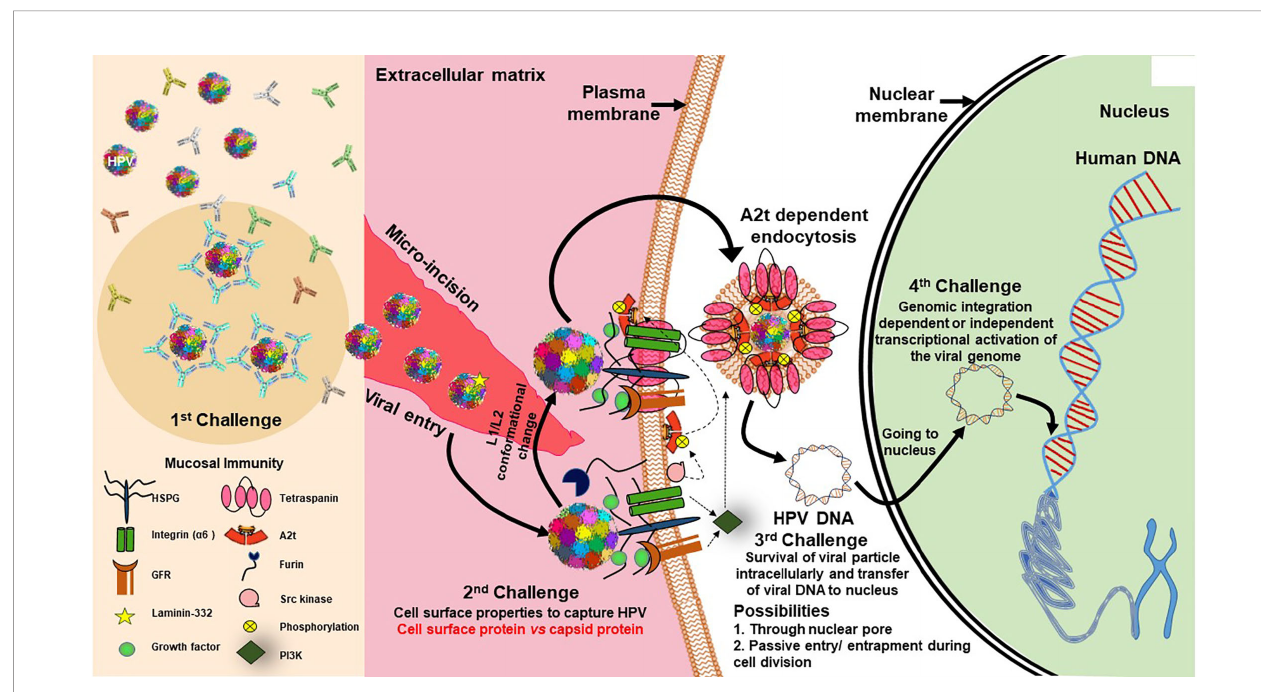
FIGURE 3 | Challenges for establishment of HPV infection in basal epithelial cells of H&N region. Establishment of transcriptionally-active HPV infection in epithelial tissues faces various challenges to establish in the host cell. First challenge is posed by the mucosal immunity against HPV coat proteins that results in clearance by HPV speci fi c antibodies (Jenson et al., 1991). Second challenge is viral entry which is speci fi cally facilitated through micro-incisions and interaction of HPV-HSPG (heparan sulfate proteoglycan)-growth factor complexes with growth factor receptors (Surviladze et al., 2012) that leads to rapid activation of signaling pathways, such as PI3K/Akt/mTOR, which further inhibit autophagy of cell for viral bene fi t (Surviladze et al., 2013). Further, src kinase phosphorylates annexin A2(AnxA2) at Tyr23 (A2t), HPV recognizes A2t and binds to it in Ca 2+ dependent manner and A2t dependent endocytosis of HPV particle and support traf fi cking of virus in cell (Dziduszko and Ozbun, 2013). Third challenge is presented for the viral DNA for survival in intracellular milieu and its transport to the nucleus, which could likely be through a passive entry/entrapment during cell division. Last and most pivotal challenge is presented for its genomic integration and transcriptional activation of viral genome to produce functional E6/E7 transcripts. In the absence of transcriptionally activation of E6 and E7, the lesion is similar to HPV negative lesion. On the other forced expression of E6/E7 can independently derive keratinocyte